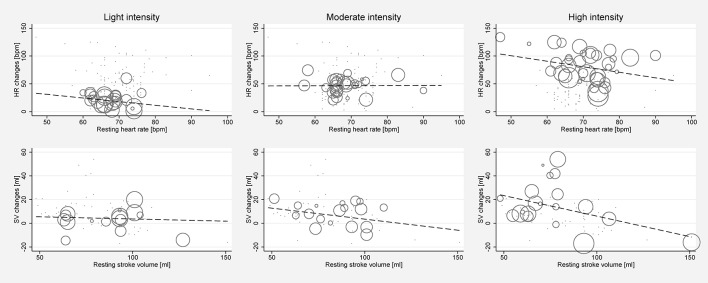
Univariate meta-regression analyses investigating the dependency of absolute mean changes of HR and SV of mean resting HR and mean resting SV in healthy subjects for all stress intensities. First row: Correlation of mean resting HR and HR changes for light intensity (coefficient −0.653, p = 0.341, adjusted R2 = 0%), moderate intensity (coefficient 0.022, p = 0.963, adjusted R2 = 0%) and high intensity (coefficient −0.995, p = 0.143, adjusted R2 = 3.45%). Second row: Correlation of mean resting SV and SV changes for light intensity (coefficient −0.0367, p = 0.839, adjusted R2 = 0%), moderate intensity (coefficient −0.187, p = 0.36, adjusted R2 = 0%), and high intensity (coefficient −0.346, p = 0.096, adjusted R2 = 25.58%). Bubble size indicates study sample size.